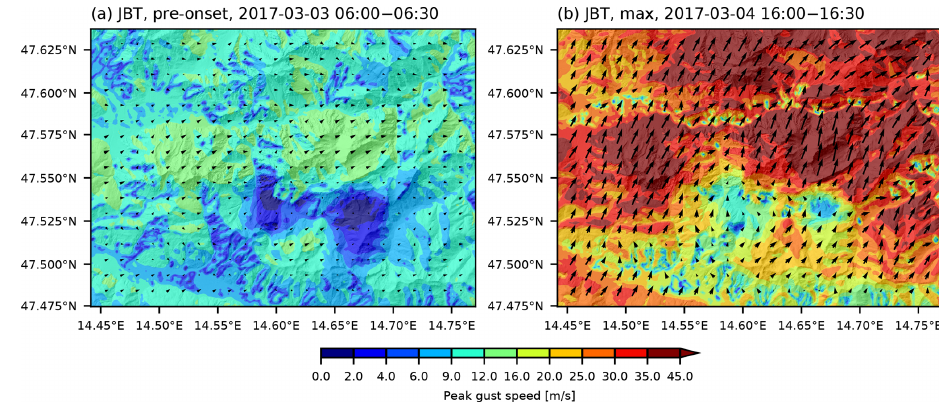
Figure 4. Modeled wind gust fields for the WegenerNet Johnsbachtal area before and during the passage of midlatitude Cyclone Xaver.